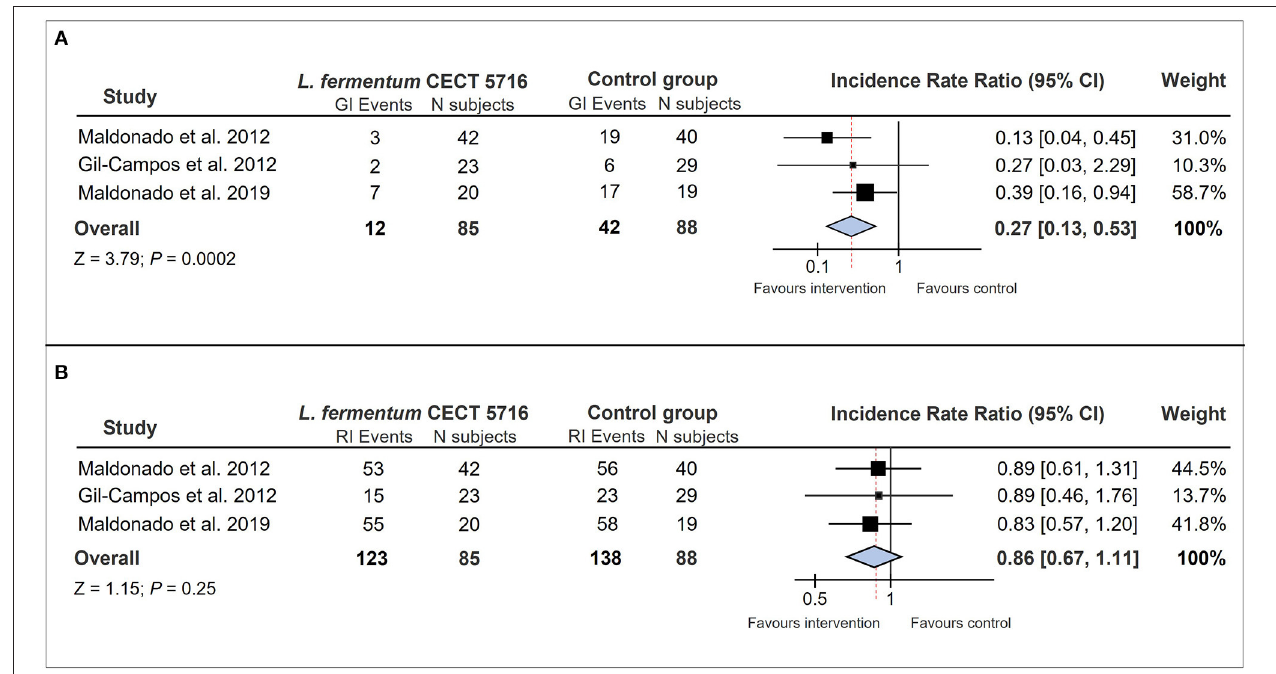
FIGURE 1 | Forest plots illustrating the effect of L. fermentum CECT 5716 interventions on (A) the incidence of gastrointestinal infections and (B) the incidence of respiratory infections in infants born by CS. CI, confidence interval; GI, gastrointestinal infection; RI, respiratory infection; N subjects, number of volunteers participating in each study-intervention